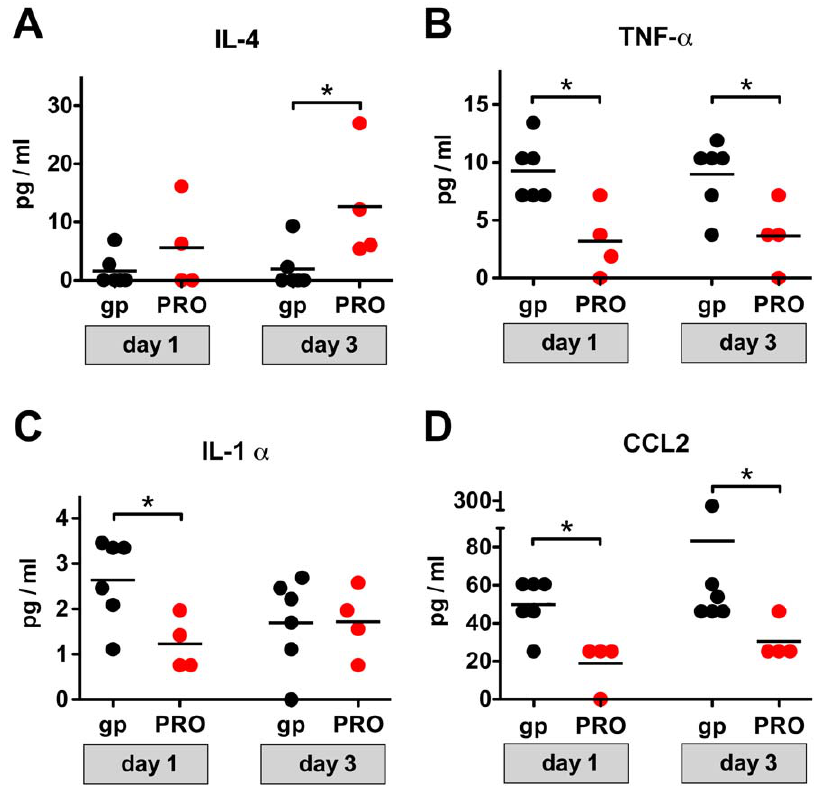
Figure 5. Immunomodulary activity of PRO 2000. Mononuclear cells derived from the vagina-draining Inguinal lymph nodes of vaginally immunized mice (described in Figure 3A–C) were cultured in the presence of 15 m g/ml of gp140, and the concentrations of cytokines/chemokines in supernatants were quantified on day 1 and 3 of the culture by multiplex assay. ( A ) IL-4, ( B ) TNF- a , ( C ) IL-1 a , ( D ) CCL2. Results for individual mice are displayed. gp , gp140; PRO , combination of gp140 and PRO 2000. * p , 0.05.